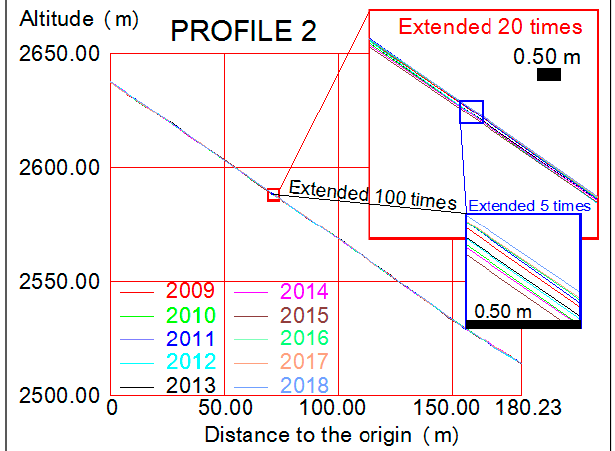
Figure 4. Representation of the annual evolution (2009–2018) of profile 2 of cone A (see Figure 3). The blue box is amplified x100 times with respect to the original profile (red box).